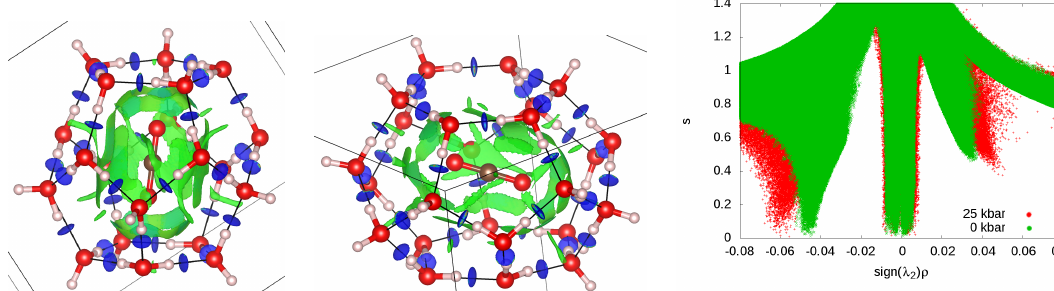
Figure 7. ( left, center ): Isosurface of the RDG ( s = 0.5). The color is determined by the value of the density times the second eigenvalue ( − 0.03 is blue and 0.03 is red ). The P cage ( left ) and the H cage ( center ) are shown, both with the most stable orientation of the CO 2 molecule. ( right ): plot of the RDG vs. sign ( λ 2 ) ρ in the whole crystal at two different